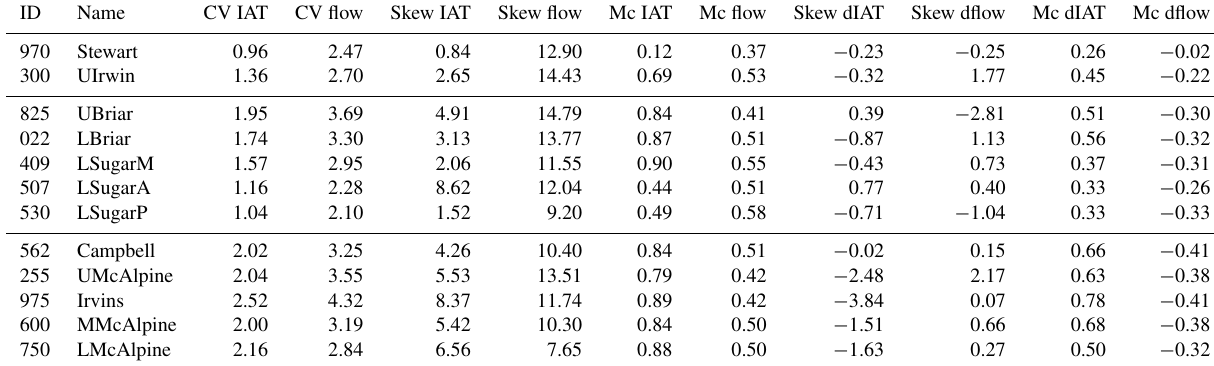
Table 4. Summary statistics of time series for flows and inter-amount times, at 24h sampling scale: coefficient of variation (CV), skewness (Skew) and medcouple (Mc), for three sets of connected sub-basins in the Charlotte catchments: Irwin, Little Sugar and